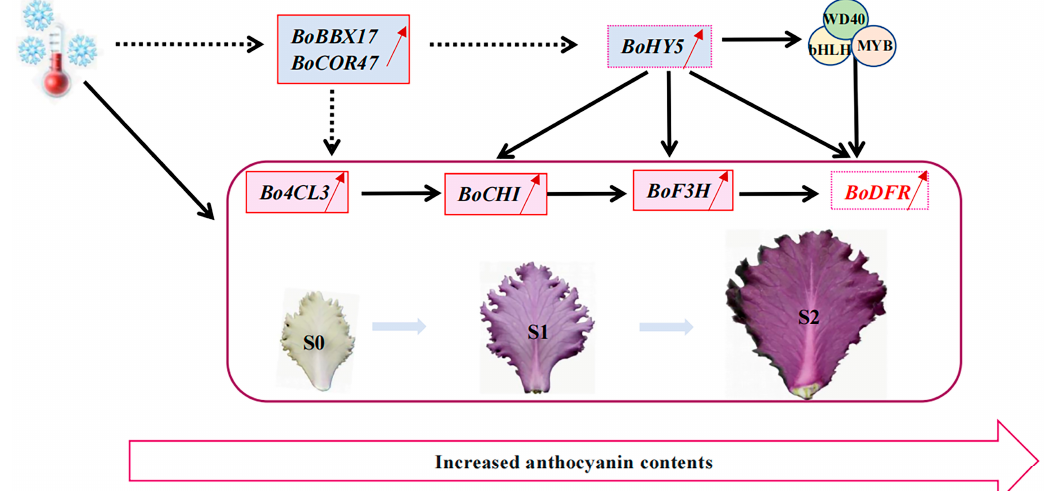
Figure 9. A possible regulatory network of anthocyanin accumulation in the process of new leaf reddening of ornamental kale under low temperature. Red solid box represents the upregulated DEGs in all three comparisons (S1 vs. S0, S2 vs. S1, and S2 vs. S0); Pink dashed box represents the upregulated DEGs in S2 vs. S0; Solid line indicates direct interaction; Dotted line indicates indirect interaction.